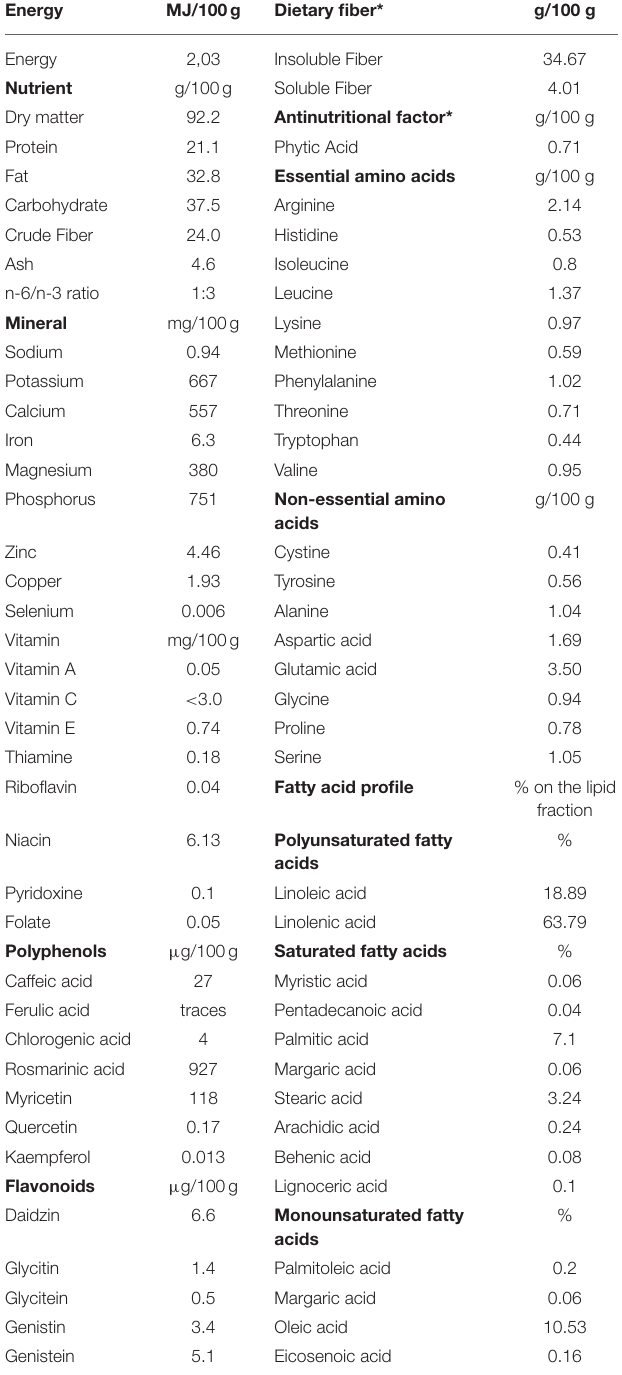
TABLE 4 | Nutritional mean value of Salvia hispanica L. seeds (14, 20–22,